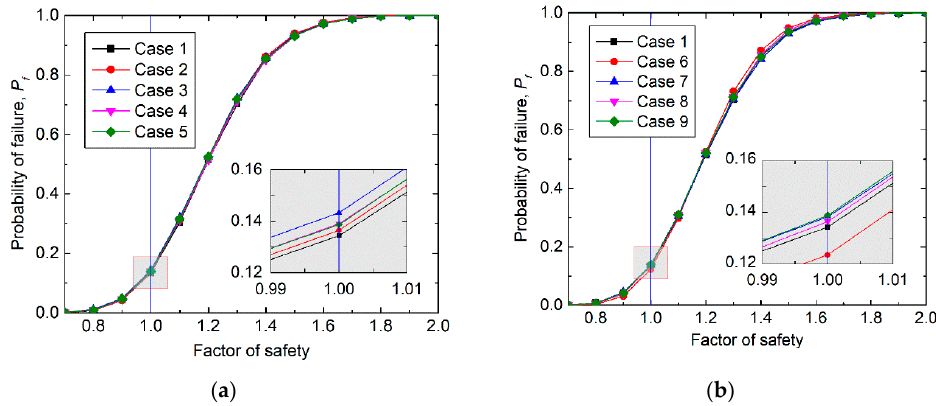
Figure 5. Cumulative distribution functions (CDFs) for different cases: ( a ) Case 1–5; ( b ) case 1 and 6–9.